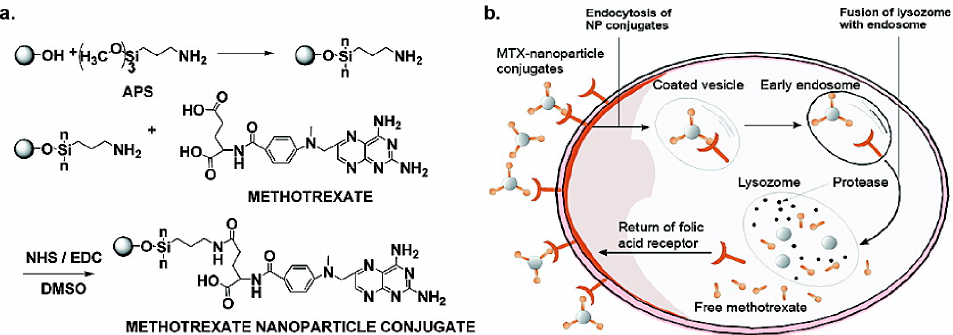
Figure 6. ( a ) Surface modification of magnetite nanoparticles with methotrexate (MTX). ( b ) Schematic representation of MTX release in simulated lysosomal pH conditions. (Adapted with permission from Reference [104]; Published by American Chemical Society, 2005).